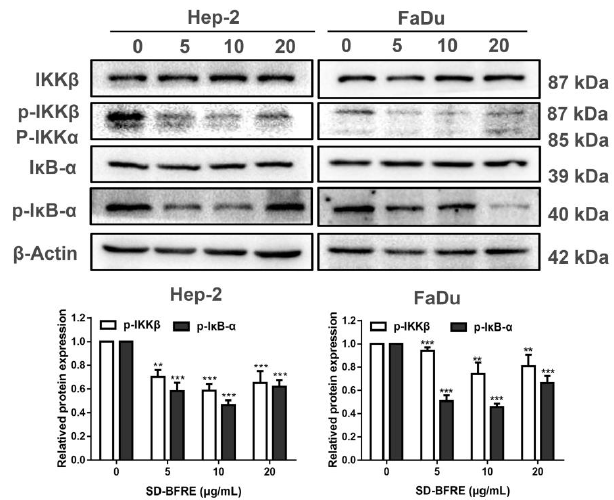
Figure 7. SD-BFRE suppresses NF- κ B p65 transcription by regulating IKK β kinase. ( A ) The relative Figure 7. SD-BFRE suppresses NF- κB p65 transcription by regulating IKKβ kinase. ( A ) The relative gests that SD-BFRE down-regulated the expression of p-Akt and p-Bad, but barely inhib- expressions of p-IKK β , IKK β , p-I κ B α and I κ B α were detected by Western blot assay of TC cells, expressions of p- IKKβ, IKKβ, p - IκBα and IκBα were detected by Western blot assay of TC cells , ited the overall expression levels of Akt and Bad protein in cancer cells. This indicated respectively incubated with SD- BFRE for 24 h. β -actin was served as an internal reference (** p < 0.01 respectively incubated with SD-BFRE for 24 h. β -actin was served as an internal reference (** p < 0.01 that SD-BFRE inhibits the proliferation of TC cells in vivo and in vitro through the or *** p < 0.001, compare to 0 μg/mL). or *** p < 0.001, compare to 0 µ g/mL). PI3K/Akt signaling pathway. 2.8. SD-BFRE Induces Apoptosis by Modulating the Akt/Bad Pathway in Vivo and in Vitro In cancer cells, protein kinase B (Akt, PKB) can regulate a variety of signaling path- ways, including inhibiting cell apoptosis. Moreover, NF- κB can be regulated by the PI3K/Akt signaling pathway, then eventually translocate to the nucleus where it sup- presses tumor cells apoptosis [27]. In order to detect whether SD-BFRE induced apoptosis is related to the PI3K/Akt pathway, in vitro and in vivo Western blot assay was applied to visualize the expression of related proteins. As shown in Figure 8A,B, the result sug-